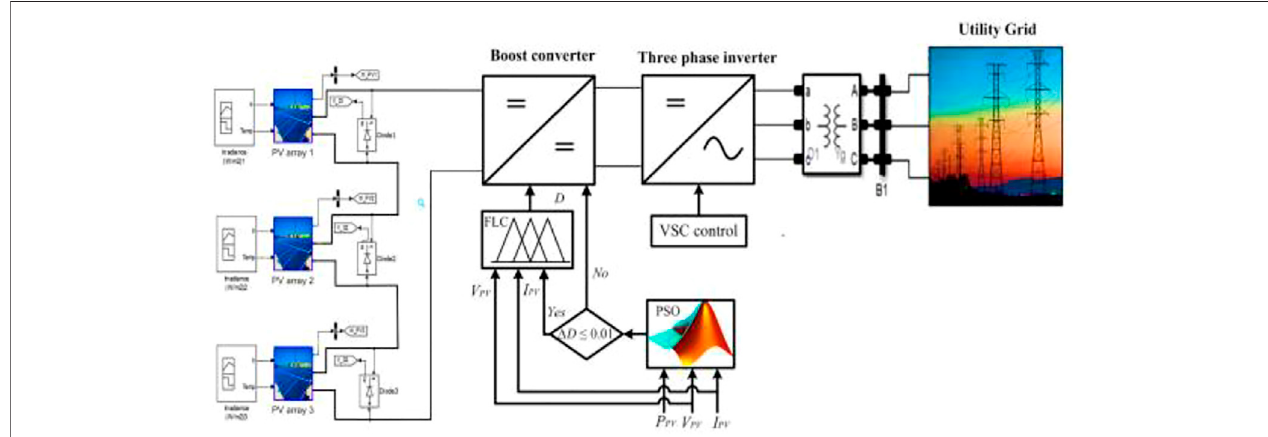
FIGURE 7 | PV based hybrid system MATLAB schematics (Gonzalez-Longatt,